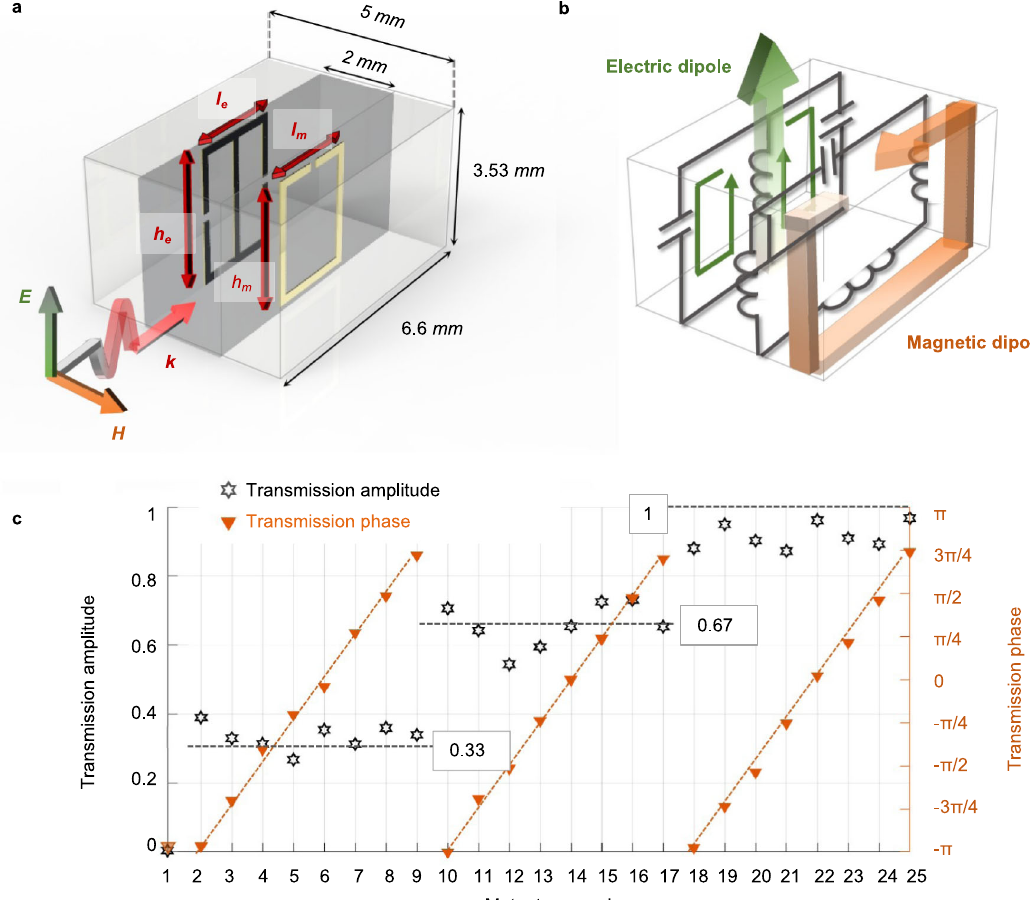
Fig. 3 Design of Huygens ’ metasurface processor. a Geometric structure of the proposed elementary Huygens ’ meta-atom patterned on both sides of the dielectric substrate ( ε r ¼ 3 ; tan δ ¼ 0 : 002). b Surface currents and equivalent electric circuits of the proposed meta-atom. The green line with arrows and orange arrows indicate the surface electric and magnetic current respectively. c Simulated transmission amplitude and phase of 25 extracted meta-atoms by modulating the geometrical parameters l e , h e and l m , h m at 10